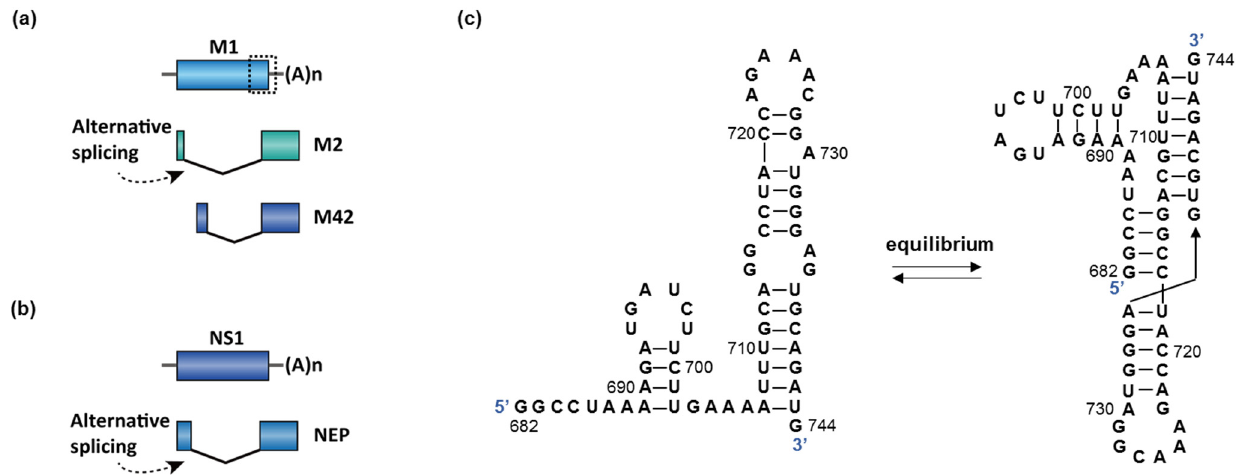
Figure 6. ( a , b ) Two genes in influenza A undergo splicing: M and NS1. The dotted box in M is the proposed region responsible for splicing switch (enlarged in ( c )). The spliced isoform of NS1 is named nuclear export protein (NEP). ( c ) An equilibrium between a hairpin and a pseudoknot structure was proposed to control the splicing of M in influenza A [115].